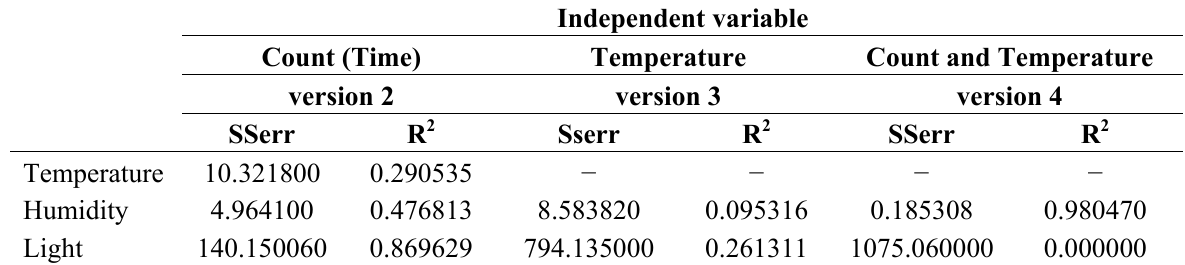
Table 7. Performance results of the SSerr and R 2 from all versions in scenarios #2, #3 and